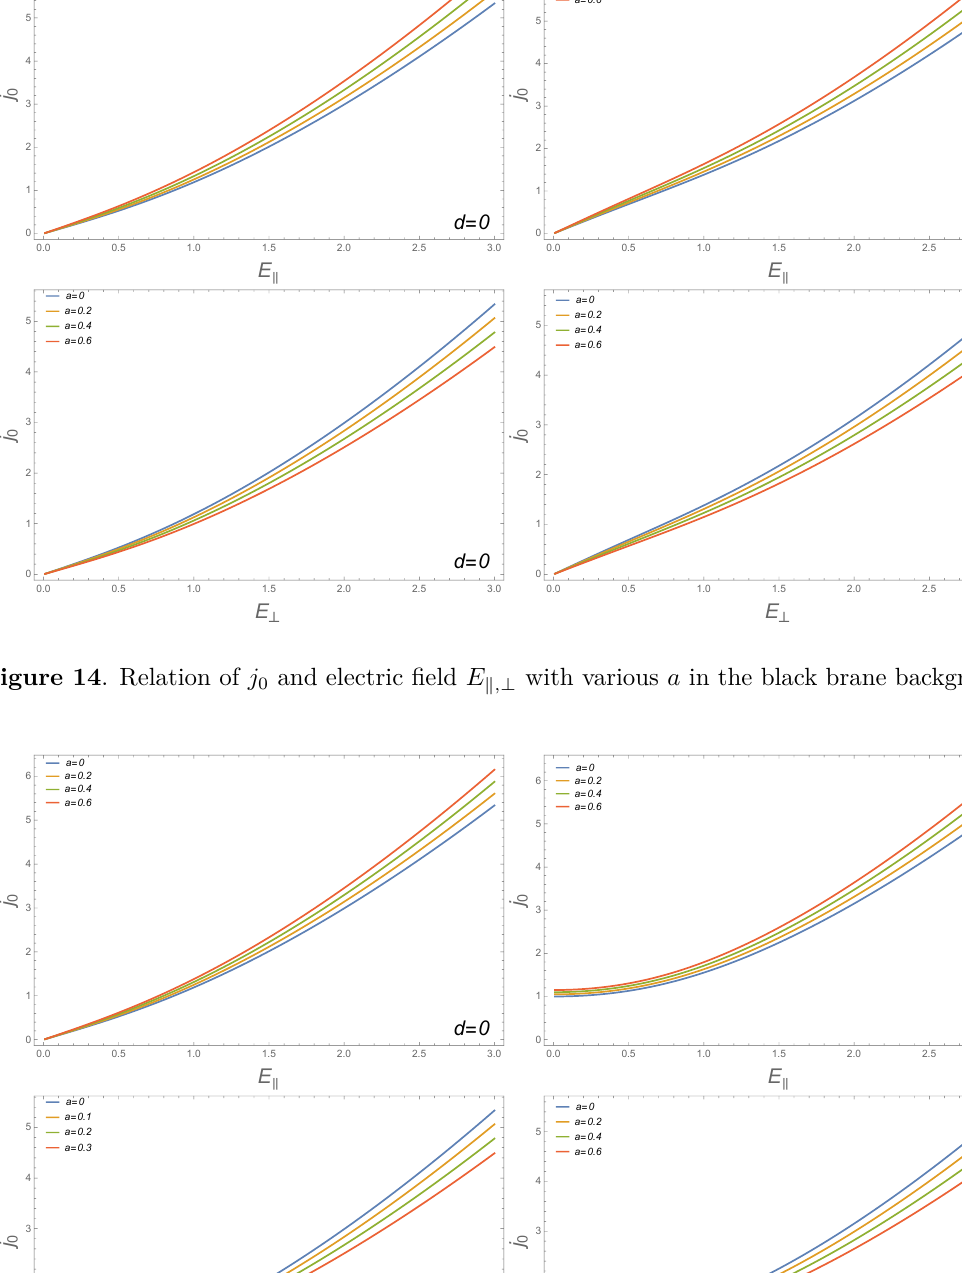
with various a in the bubble k , ⊥